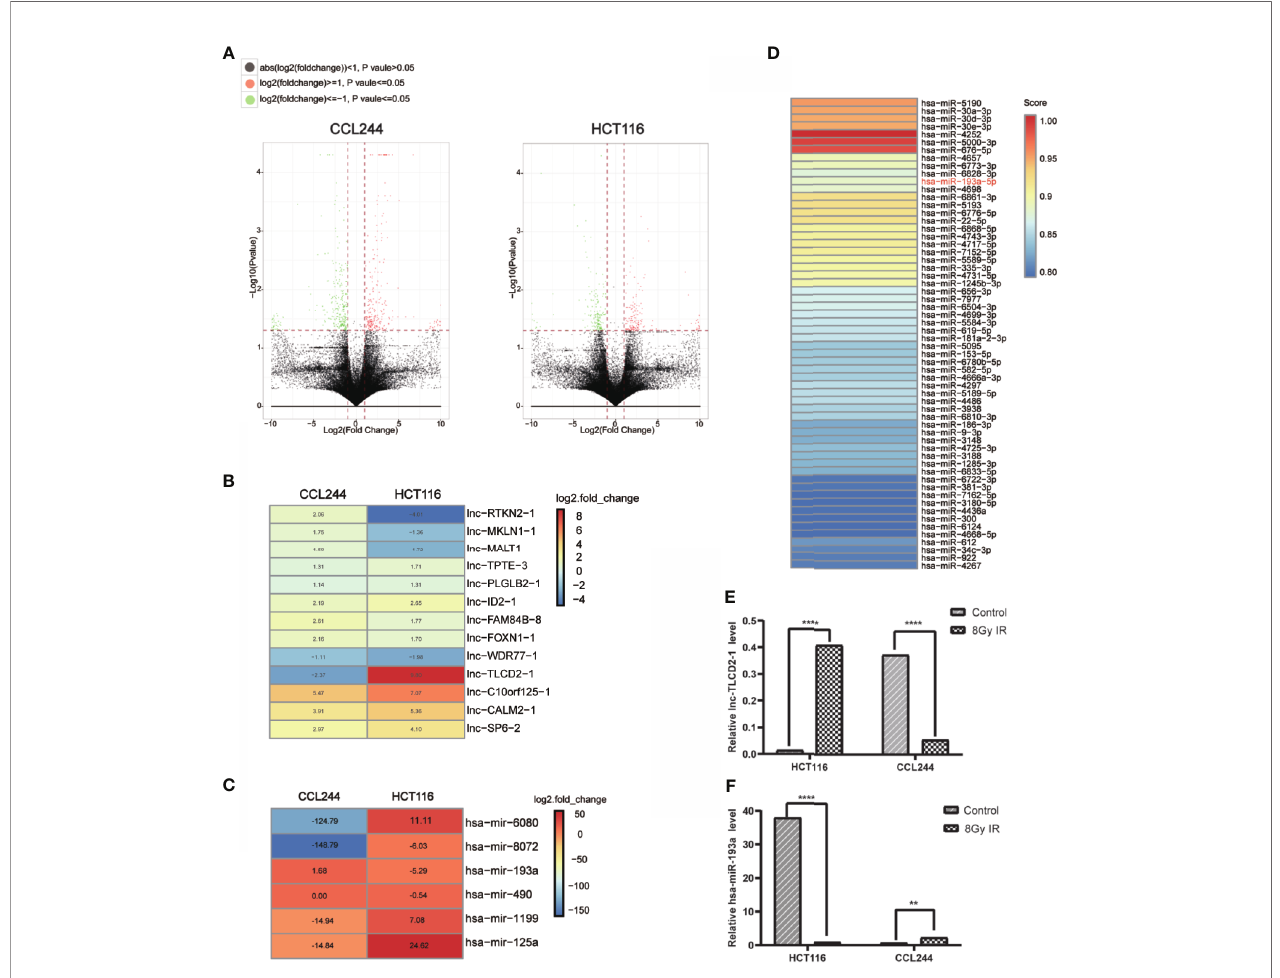
FIGURE 1 | Difference in RNA expression between CCL244 and HCT116 after irradiation. (A) LncRNAs differentially expressed in CCL244 and HCT116 after 8 Gy radiation exposure. (log2(foldchange)>=1 or log2(foldchange)<=-1, and p value<=0.05 were considered a statistically signi fi cant difference). (B) CCL244 and HCT116 co-exist differentially expressed lncRNAs. (C) Six miRNAs with differences were detected. (D) Starbase database predicted the interaction of lnc-TLCD2-1 with miRNA (Score>=0.8). (E) The expression of lnc-TLCD2-1 was signi fi cantly changed after radiation. (F) MiR-193a-5p was signi fi cantly changed after radiation. (P<=0.05 means statistically signi fi cant, **p < 0.01, ****p <